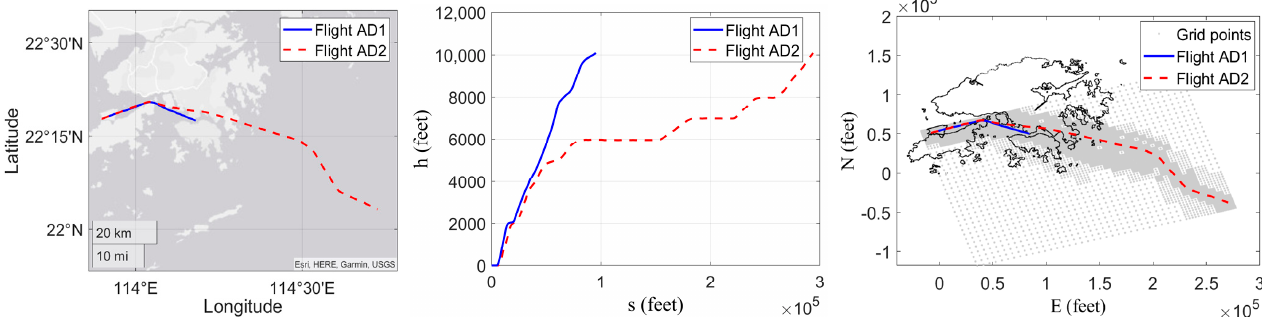
Figure 9. A330 aircraft departing from HKIA. Flights AD1 and AD2 respective routes (left: ground track, center: flight profile) and corresponding ground observers (dynamic grid, right).